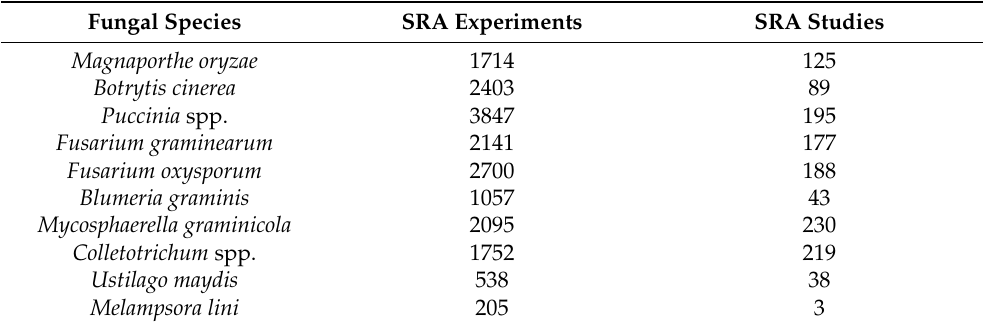
Table 1. Overview of RNA-Seq experiments and data in the NCBI Short Read Archive (SRA 1 ) for the 10 most relevant fungal